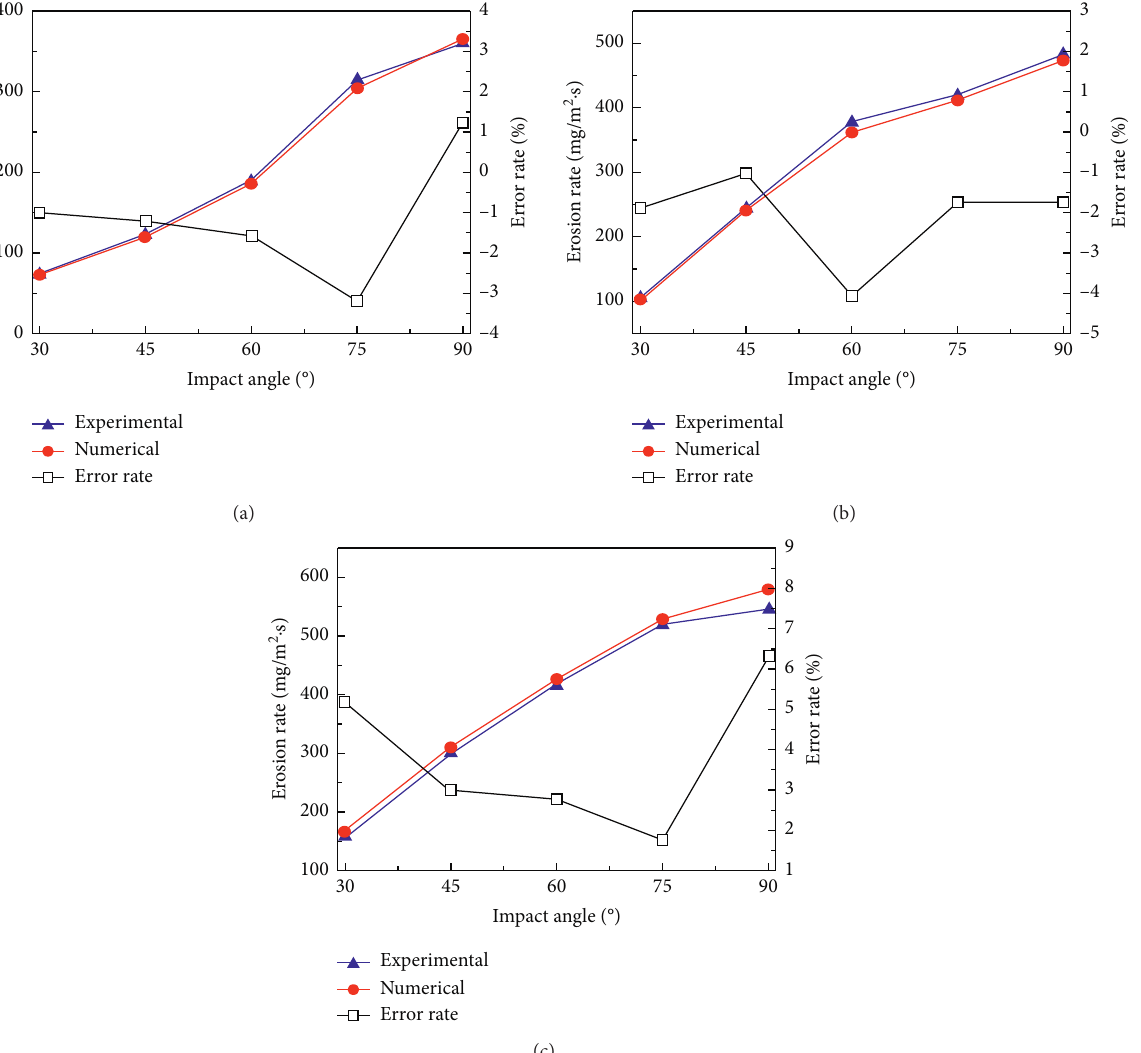
Figure 3: Experimental results, numerical results, and the error rates between them of wind erosion on smooth wall surfaces under different wind velocities: (a) 19m/s; (b) 23m/s; (c) 26m/s. Table 1: Erosion rates of grooved and smooth wall surfaces under different wind velocities and impact angles. Impact